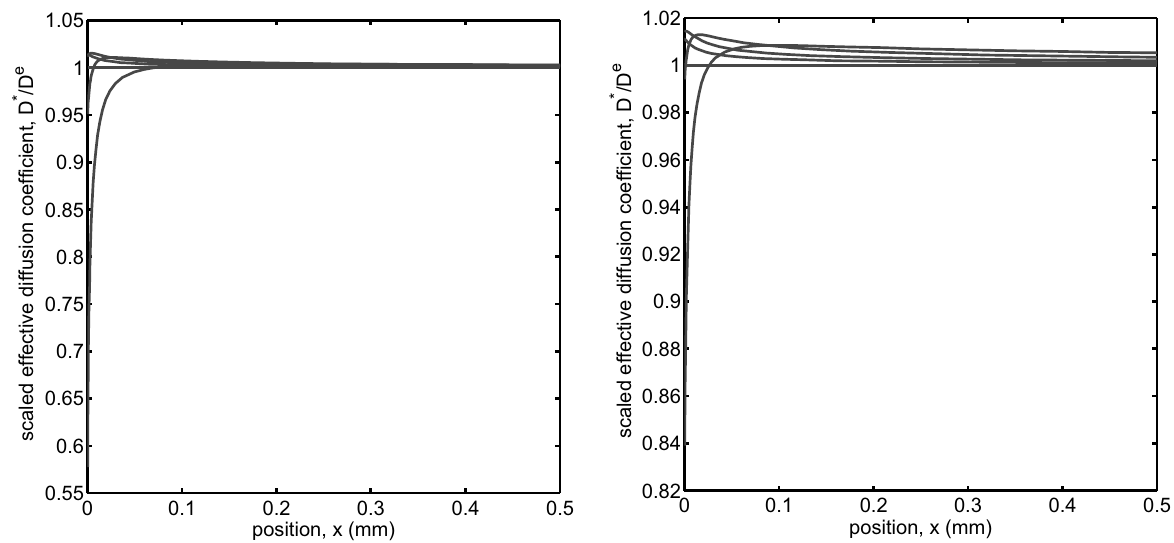
Fig. 4 – Bulk diffusion constant D ∗ ≡ − jx / [h n i ( x ) − h n i ( 0 ) ] scaled with D e ≡ 2 / [ 1 / D 1 + 1 / D 2 ] [Eqn. (17)] as a function of position x (mm), decreasing monotonically at x = L with increasing particle volume fraction φ = φ ∗ ( 0 , 0 . 1 , 0 . 2 , 0 . 4 , 0 . 8 ) = μ C cm − 2 (left panel); constant ζ -potential ζ ( 0 , 0 . 0534 , 0 . 1069 , 0 . 2137 , 0 . 4275 ) 3 : constant charge density σ × 10 − = 1 / e − 4 kT ≈ − 100 mV (right panel). The accompanying bulk electrolyte concentration gradient is practically constant. See text and Tables I–III for other microscale